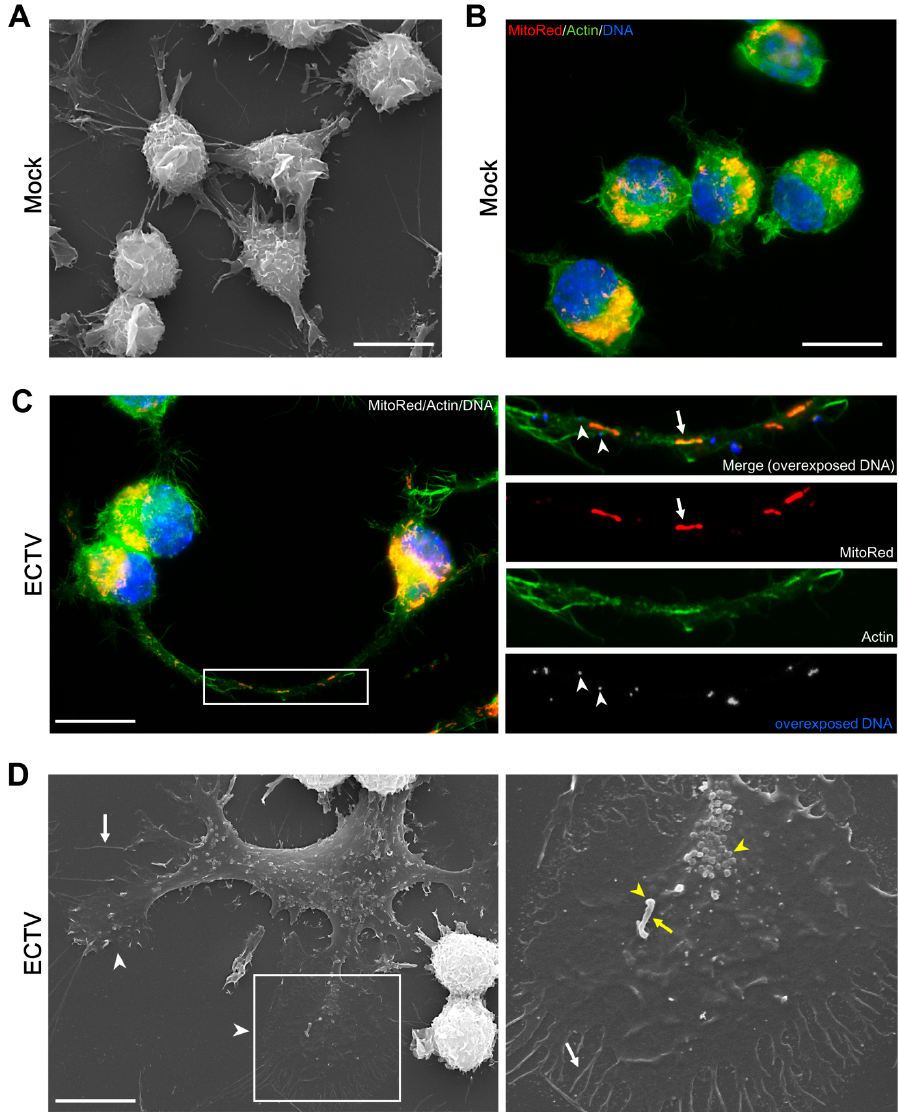
Figure 2. Morphology of RAW 264.7 cells during ECTV infection. Scanning electron micrograph of mock- ( A ) and ECTV-infected ( D ) cells; Actin cytoskeleton in mock- ( B ) and ECTV-infected ( C ) cells. White arrows indicate mitochondria in cytoplasmic corridor ( C ) or filopodia ( D ). White arrowheads indicate progeny virions ( C ) or lamellipodia ( D ). Yellow arrow indicates actin tail ( D ). Yellow arrowhead indicates progeny virions ( D ). Scale bar: 10 µm.